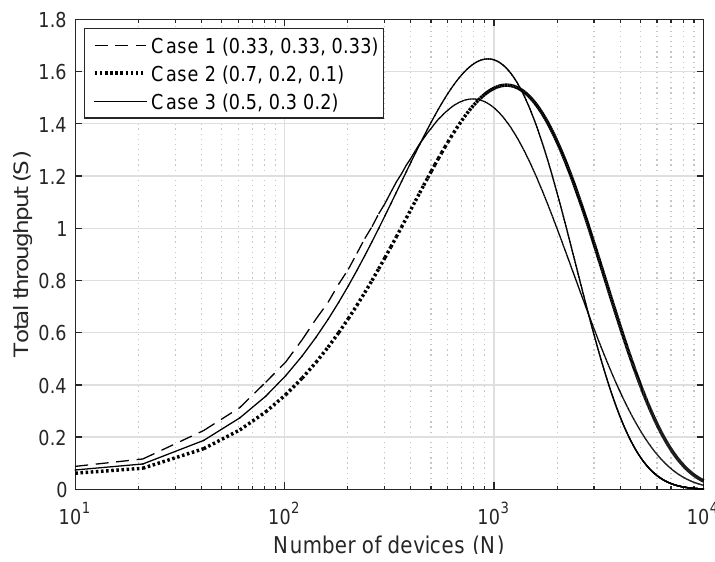
Figure 3. The comparison of the throughput according to the SF